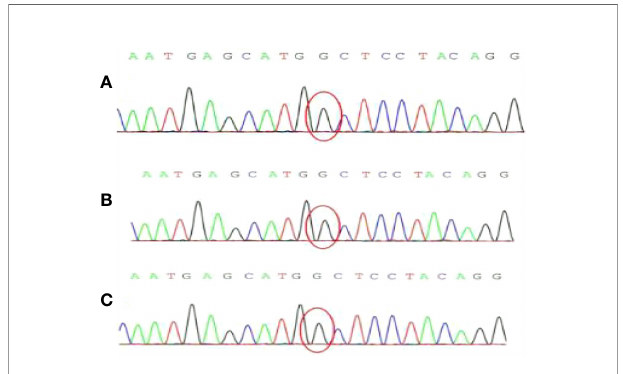
FIGURE 8 | The result of genetic fi rst-generation sequencing detection. No TSC gene mutation was found. (A) Hepatocellular carcinoma; (B) Cholangiocarcinoma; (C)